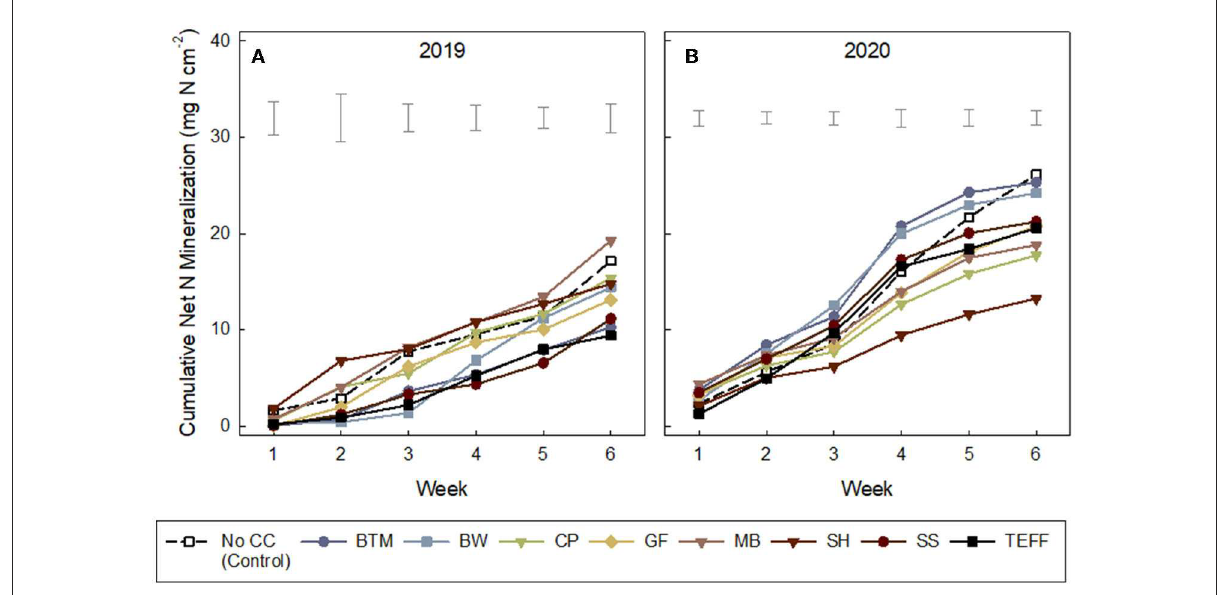
FIGURE3 (A,B) Cumulative inorganic nitrogen (ammonium-N and nitrate-N) collected on ion exchange membranes (IEMs) over a 6-week period after cover crop termination in growing cabbage. Treatments: NCC, no cover crop (Control); BTM, brown top millet; BW, buckwheat; CP, cowpea; GF, golden flax; MB, mung bean; SH, sunnhemp; SS, sorghum sudangrass; TEF, teff. Leguminous cover crops are shown in downward triangle ( ∇ ). See Table 6 for standard deviations. for final cumulative net N mineralization at Week